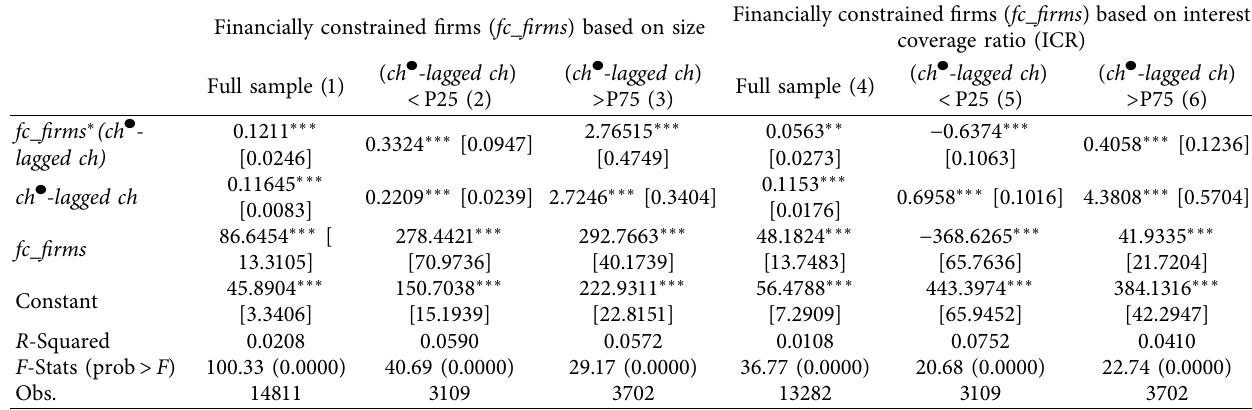
Table 7: Regression results for the speed of adjustment to the target cash holding level. Financially constrained firms ( fc_firms ) based on size